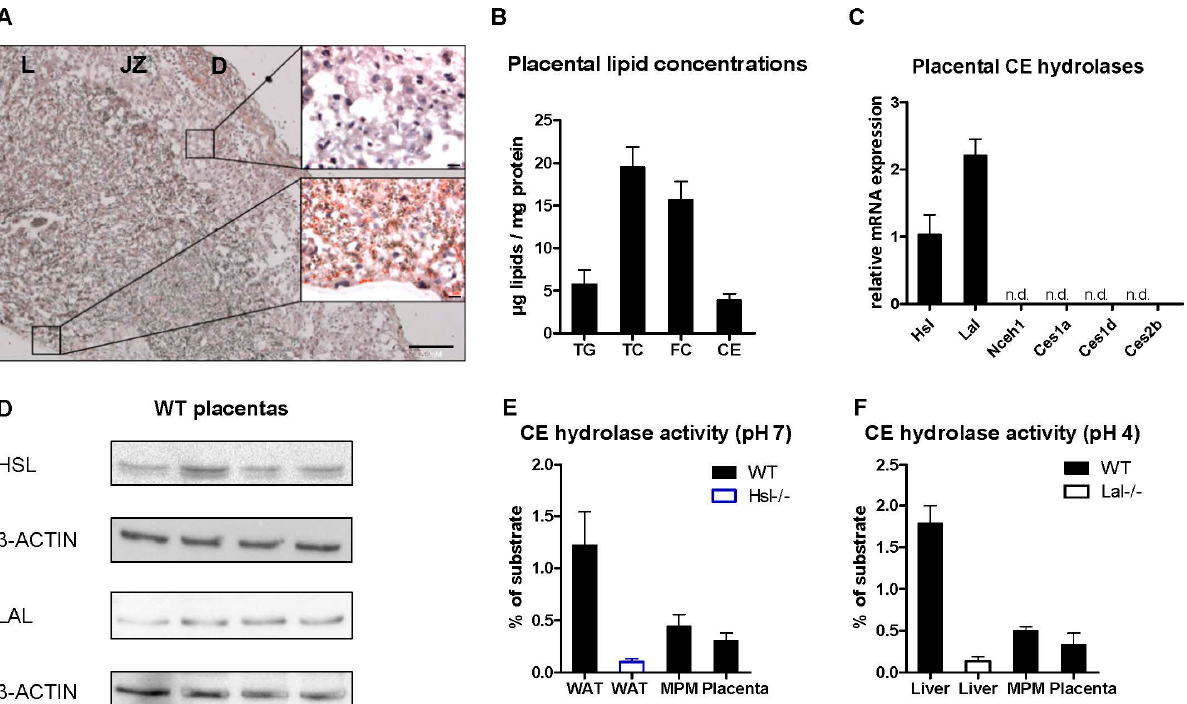
Figure 1. Intracellular cholesteryl ester (CE)-hydrolyzing enzymes are expressed and active in wild type (WT) mouse placenta. Placentas were isolated from WT mice on day 19 of pregnancy. ( A ) ORO staining of a placental section; decidua (D), junctional zone (JZ), and labyrinth (L). ( B ) Triglyceride (TG), total cholesterol (TC), free cholesterol (FC), and CE concentrations in the mouse placenta. Magnification, 4×; Scale bar, 200 µm. ( C ) mRNA expression of CE hydrolases in mouse WT placenta relative to the expression of cyclophilin A as a housekeeping gene. ( D ) Hormone-sensitive lipase (HSL) and lysosomal acid lipase (LAL) protein expression in the placenta. ( E ) Neutral and ( F ) acid CE hydrolase activities in the placenta. White adipose tissue (WAT), liver, and mouse peritoneal macrophages (MPM) were assayed as controls. Data represent mean values + SD ( n = 4 placentas from different dams and tissues/cells from different mice).